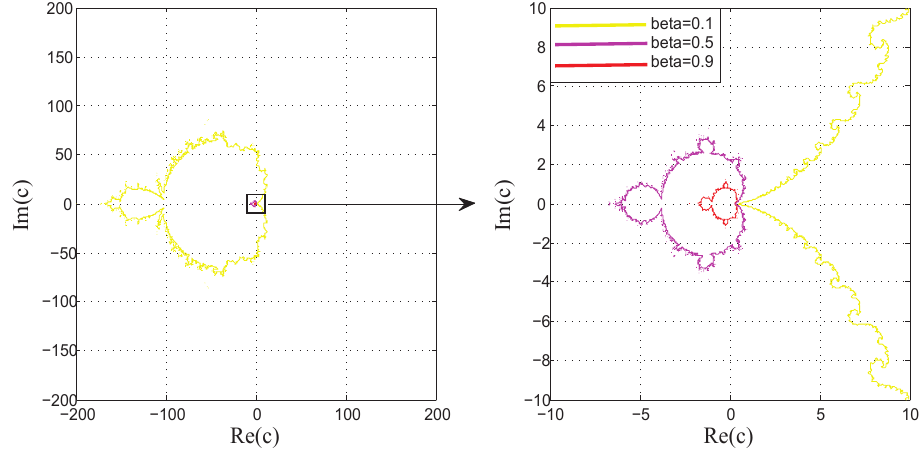
Figure 1. Superior Mandelbrot sets M ( P c ) plotted with different β .